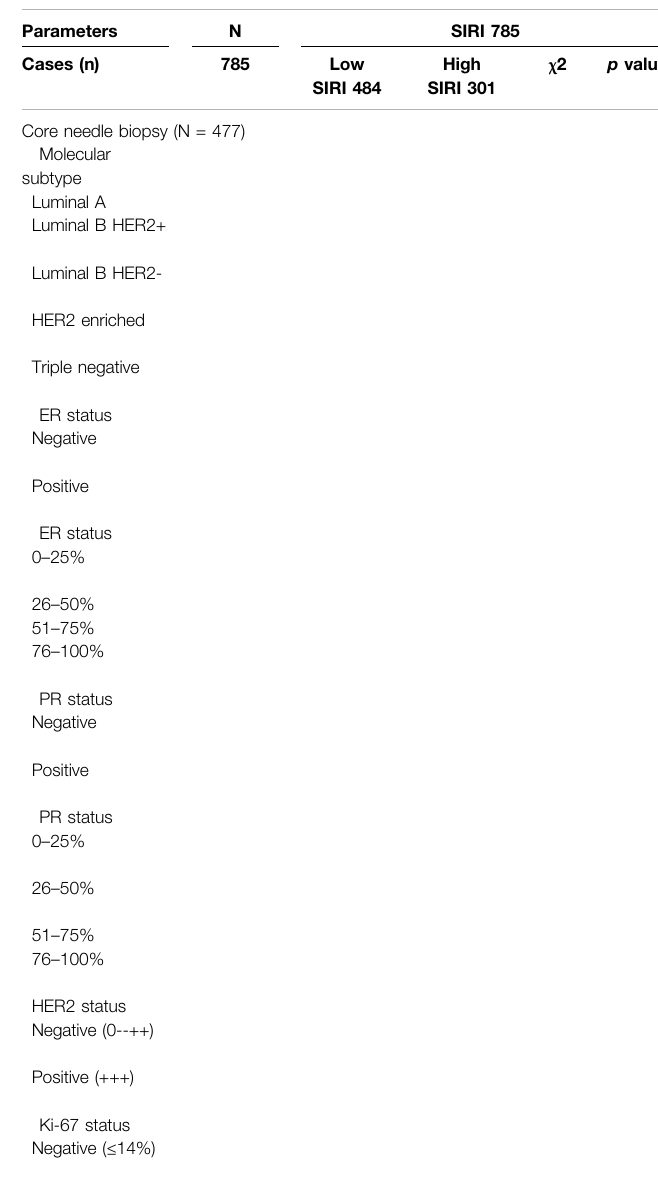
TABLE 4 | The relationship between SIRI scores and molecular breast cancer